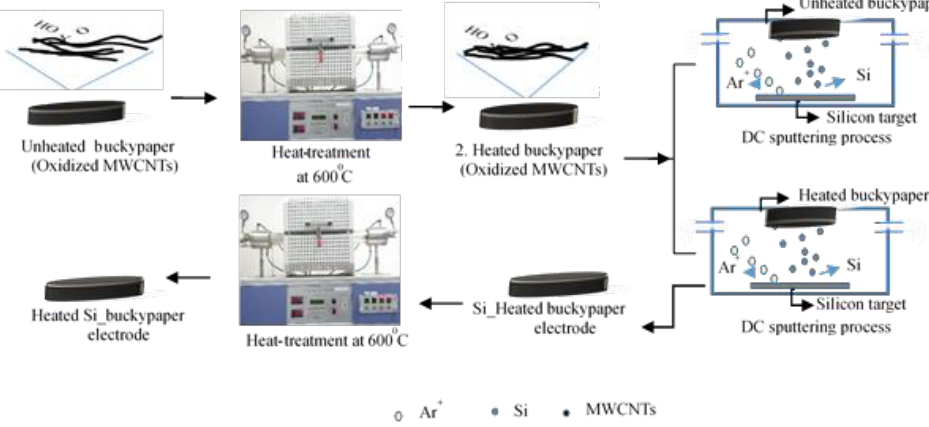
Figure 2. Schematic diagram of the electrode preparation (HBP, USi_HBP, and HSi_HBP) .